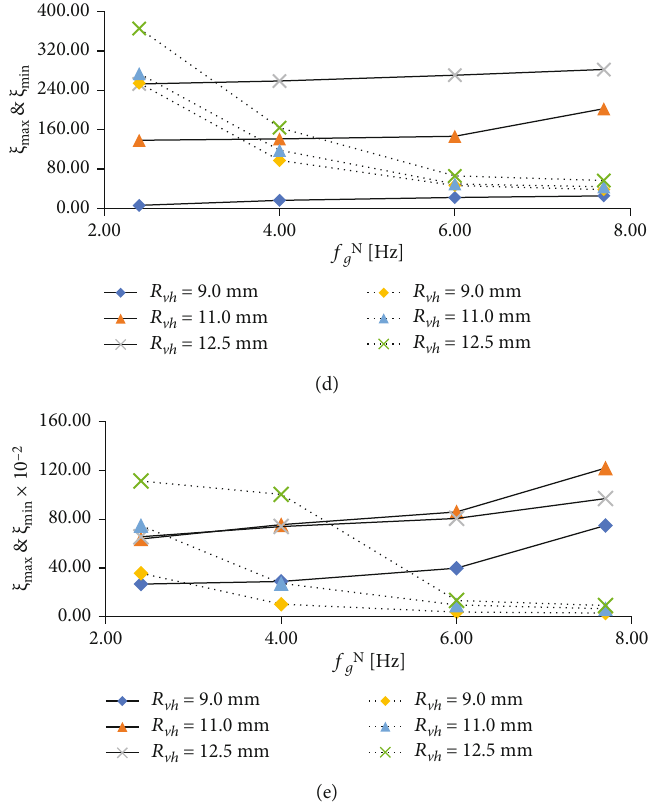
and ξ , referenced to positive (solid lines) and negative (dotted lines) max min , and radius of the vent hole, R g